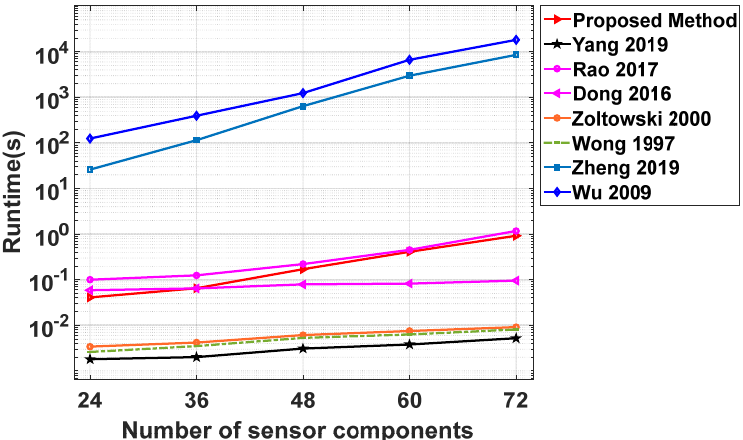
Figure 8. Runtime versus the number of sensor components.